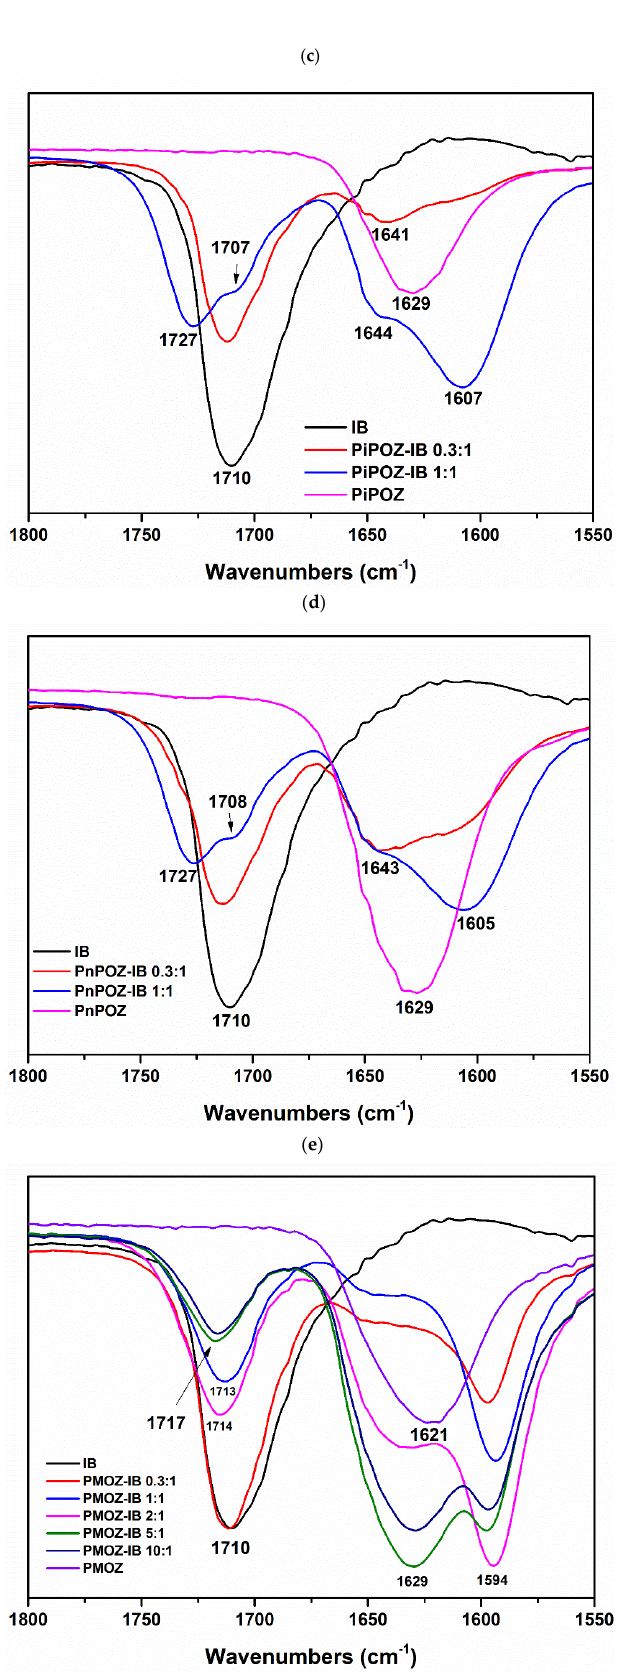
Figure 2. FTIR spectra of PVP-IB SDs ( a ), PEOZ-IB SDs ( b ), PnPOZ-IB SDs ( c ), PiPOZ-IB SDs ( d ), and PMOZ-IB SDs ( e ) in the range of 1800–1550 cm − 1 . The 1:1 ratio of IB in dispersions with PEOZ, PnPOZ, and PiPOZ showed similar infrared spectra, in agreement with that for PVP. The carbonyl stretching mode of IB showed a consistent red shift of 17 cm − 1 from 1710 cm − 1 to 1727 cm − 1 , and the carbonyl stretch in the polymers split from the single peak at 1626 or 1629 cm − 1 to give features at